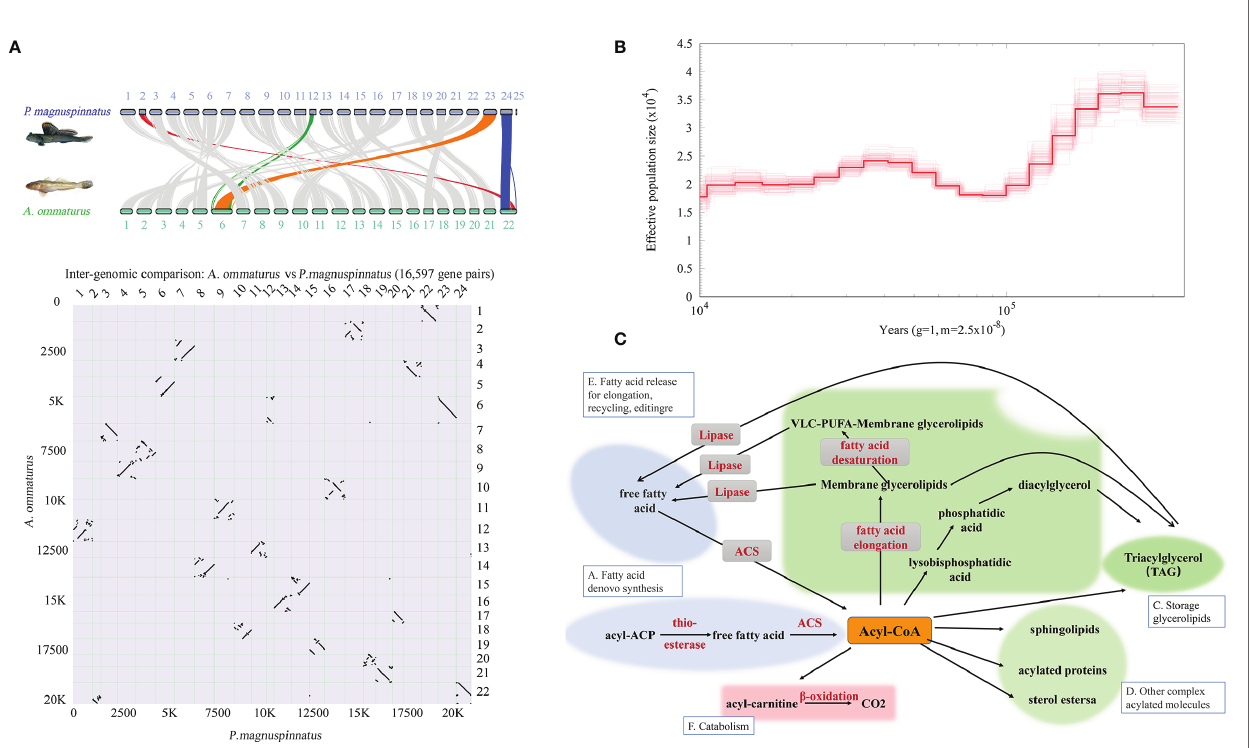
FIGURE 4 | Genome synteny between A. ommaturus and P. magnuspinnatus and population history of A. ommaturus . (A) Chromosomal syntenic relationships between A. ommaturus and P. magnuspinnatus . (B) The effective population size of A. ommaturus . (C) Central role of acyl-CoAs in cell metabolism. Adapted from Coleman et al.